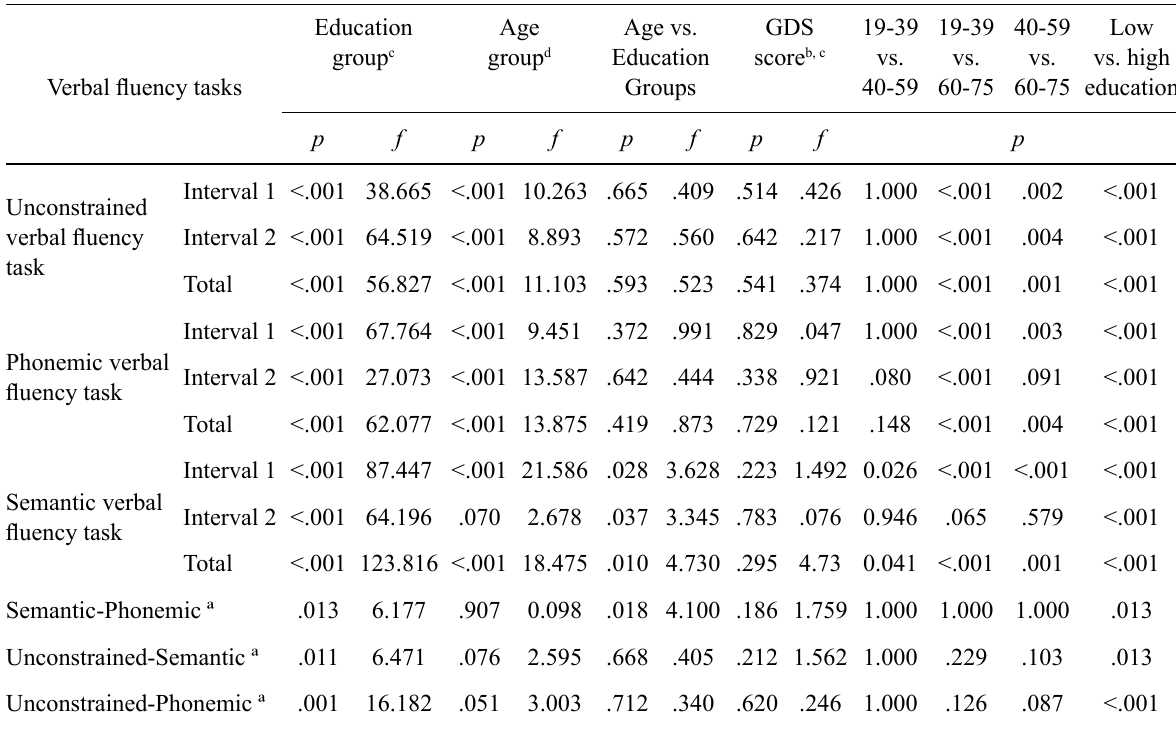
Age and Education Effects, Interactions between Variables, and Post-Hoc Results between Groups in VFT (interval, total and discrepancy score)